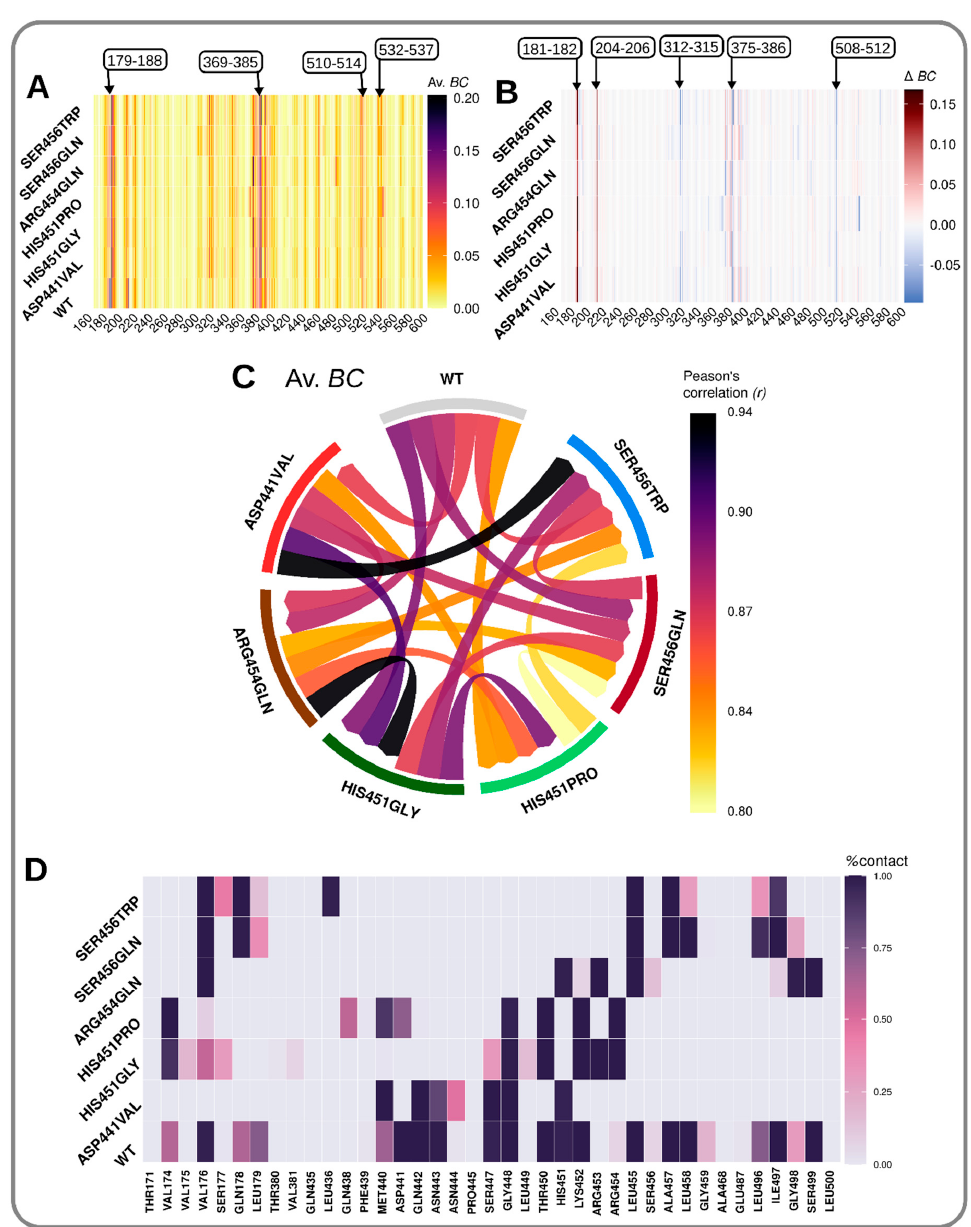
Figure 6. Analysis of average BC results: ( A ) Per residue average BC values illustrated using a heatmap. ( B ) The residue changes in average BC index ( Δ BC ) because of mutations (WT model and less mutated model). ( C ) Pairwise Pearson’s correlation among models with respect to average BC profiles: comparison of linear relationships between the WT and the six mutated models in this dataset. The color ranges from yellow: the smallest correlation value, to black: the largest correlation value. ( D ) Per residue weighted contact heatmap. Color range is from white (0% frequency of occurrence) to violet (100% frequency of occurrence). Per residue contact network map representation is shown in Figure S17.